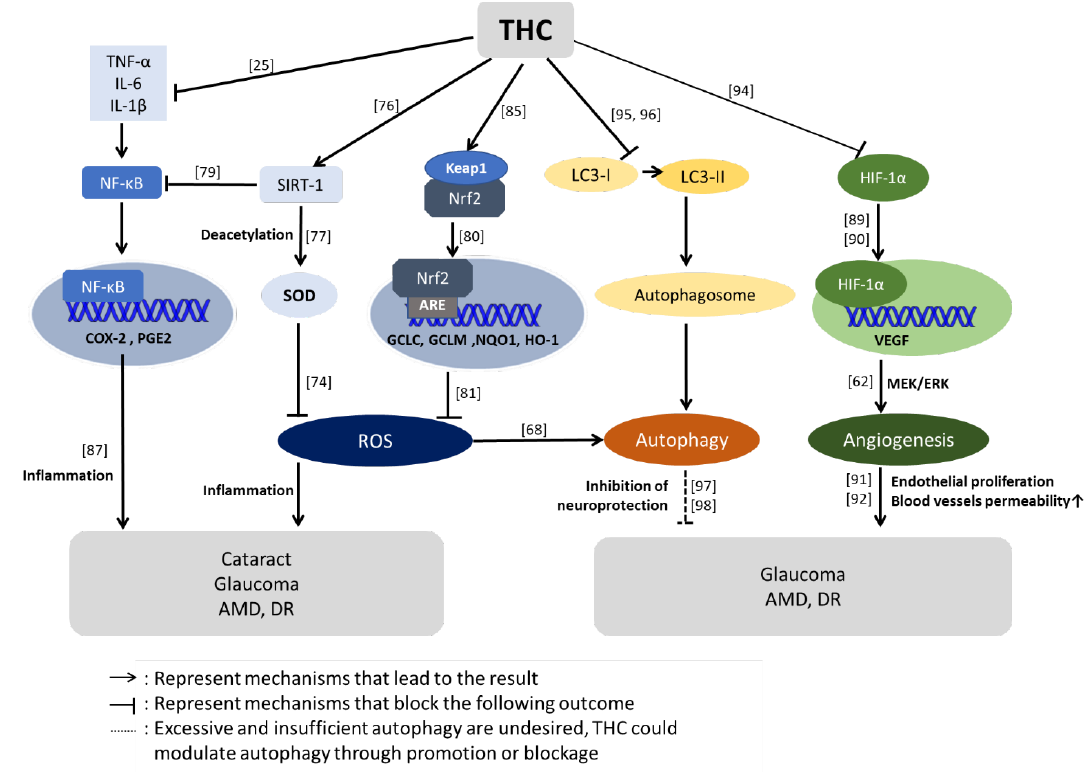
Figure 4. Possible pathways of THC-mediated protective effect on eye diseases. Regarding antioxidative stress pathways, the activation of sirtuin-1 (SIRT-1) was increased after THC treatment. SIRT-1 deacetylates SOD-1 and SOD-2 are ROS (reactive oxygen species) scavengers. However, SIRT-1 also inhibits nuclear factor-κB (NF-κB), leading to the alleviation of inflammation and oxidative stress. In addition to the SIRT-1 pathways, THC can activate antioxidative stress genes, such as heme oxygenase-1 (HO-1), by occupying the Nrf2-binding site of Keap1. Regarding the modulation of autophagy, THC balances excess and deficient autophagy. About the effect of THC against angiogenesis, THC downregulates the expression of hypoxia-inducible factor-1α (HIF-1 α ) and vascular endothelial growth factor (VEGF). As noted, because of the collective antioxidative, anti-inflammatory, and antiautophagic effects of THC and its ability to inhibit VEGF, THC plays a neuroprotective role. These THC pathways were observed in different experiments but may have valuable benefits in protecting the eye. Abbreviations: SOD: superoxide dismutase, Nrf2: nuclear factor erythroid 2-related factor 2. The different numbers in the figures are reference citations. 4. Conclusions Curcumin has been used throughout history for the prevention of various conditions. The potential benefits of curcumin in several major ocular diseases, such as age-related cataract, glaucoma, AMD, and DR, are under investigation. However, the low bioavaila- bility of curcumin limits its effective concentration. Therefore, two main approaches to overcome this issue were discussed above: the formulation of curcumin for its delivery and the use of curcumin metabolites. The former has long been intensively studied and can roughly be summarized as three strategies: lipid addition, absorption and dispersion on matrices; particle size reduction; and surface property modulation. Pharmaceutical ap- plications of cumin usually combine several methods to reach its ideal application. The latter is a relatively new field to researchers and pharmaceutical companies, and among curcumin metabolites and conjugates, THC has been the focus. Ocular diseases lead to visual impairments through oxidative stress, ER stress, inflammation, and autophagy. However, THC was found to possess antioxidative, anti-inflammatory, anti-VEGF, and neuroprotective properties in vivo and in vitro.